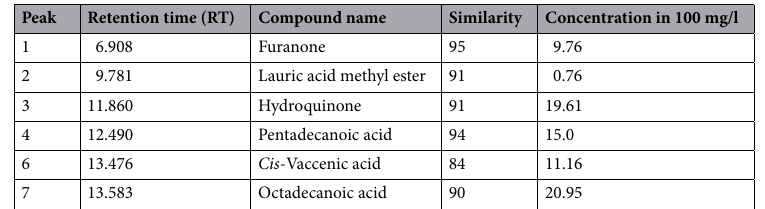
Table 8. Compound profile of Macrotermes carbonarius defense fluid determined by GC–MS, with retention time, similarity, concentration and compound activity.